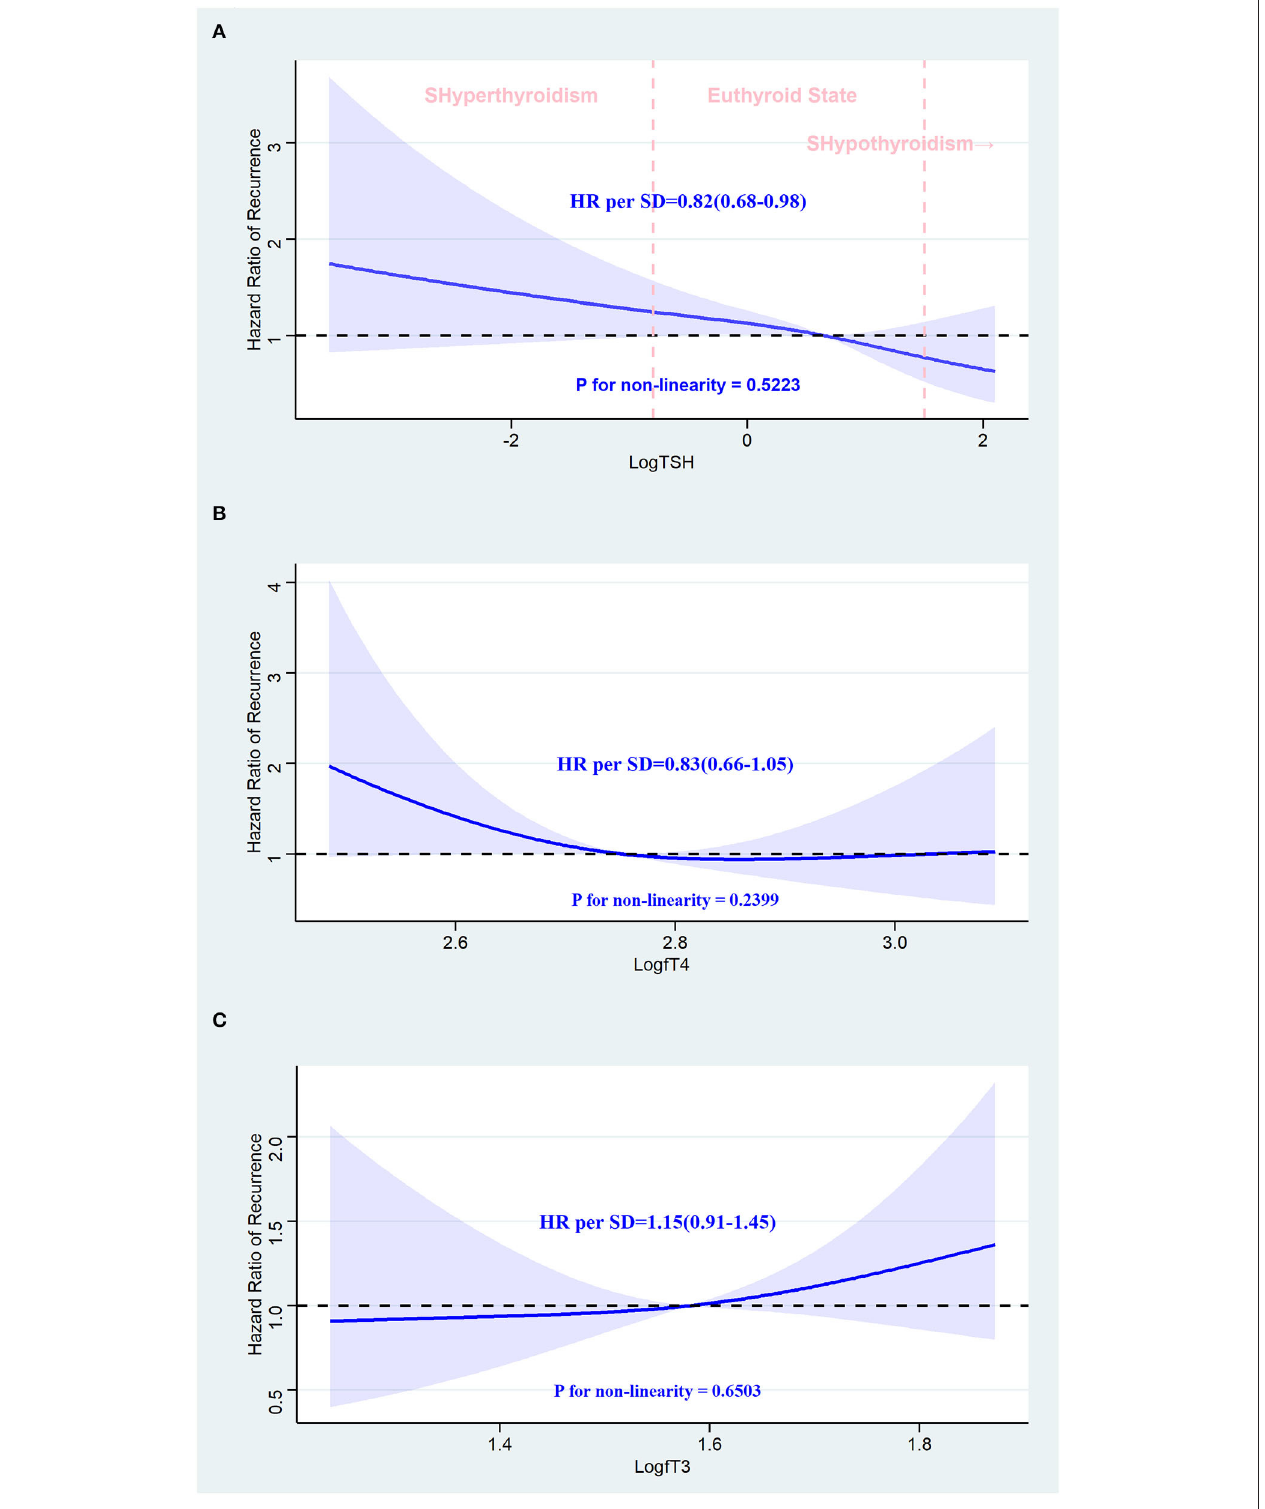
FIGURE 5 | Association between thyroid hormone and recurrence of atrial fibrillation after radiofrequency catheter ablation using a restricted cubic spline regression model. (A) TSH and recurrence of AF after RFCA. (B) fT4 and recurrence of AF after RFCA. (C) fT3 and recurrence of AF after RFCA. Results are adjusted for age, BMI, gender, current smoking and drinking status, AF pattern, CHA2DS2-VASc score, AF duration, echocardiogram information, past diagnoses, current medications,